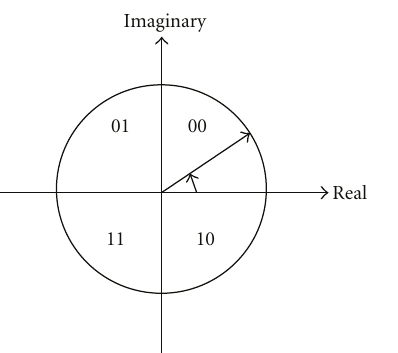
Figure 3: Real and imaginary axes and related binary codes. Figure 4: Iris features in the real/imaginary plane. The features near the axes are more inconsistent than